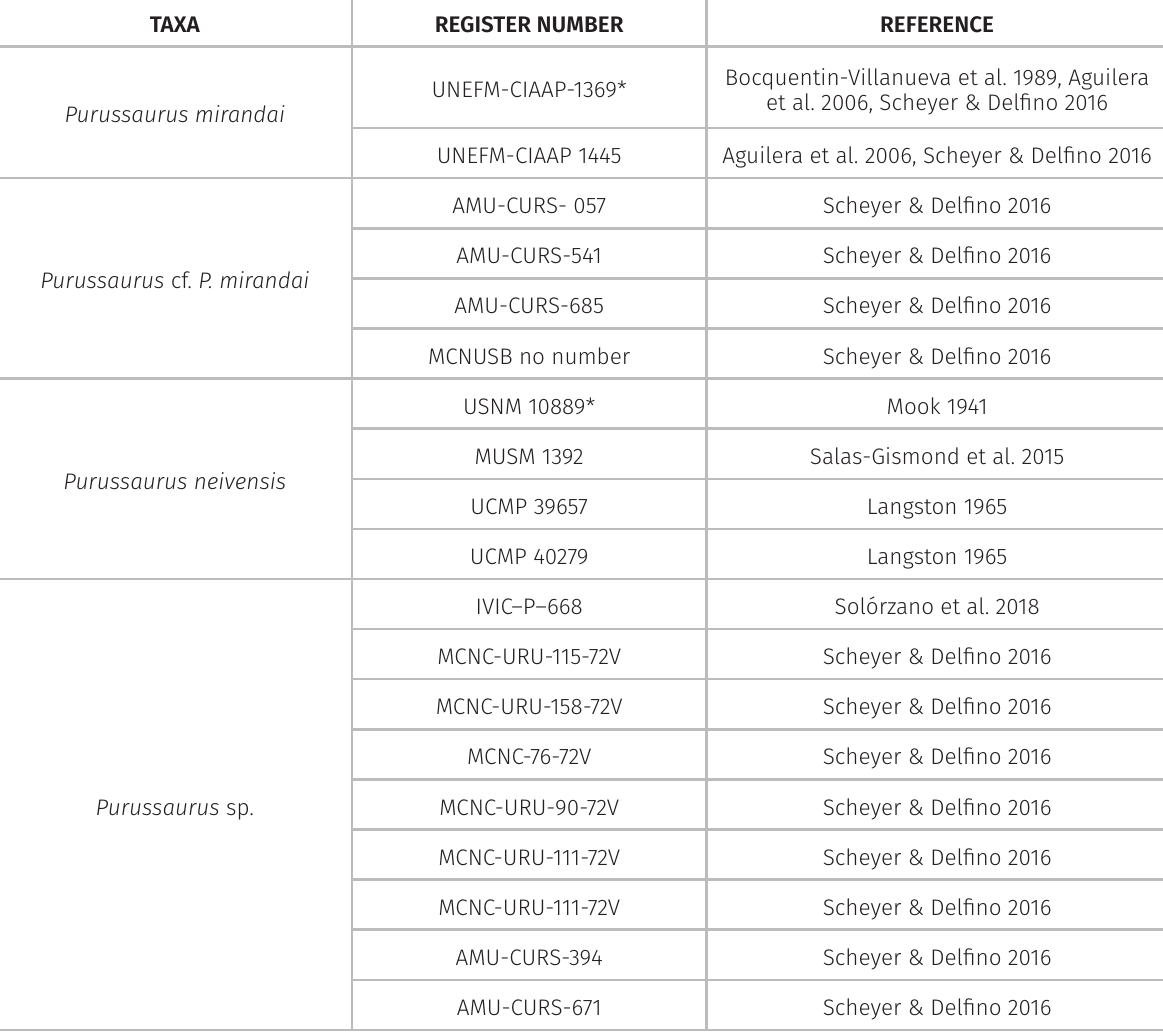
Table I. The studied mandibular elements of Purussaurus mirandai , P. neivensis and Purussaurus sp. specimens. Legend: *, type